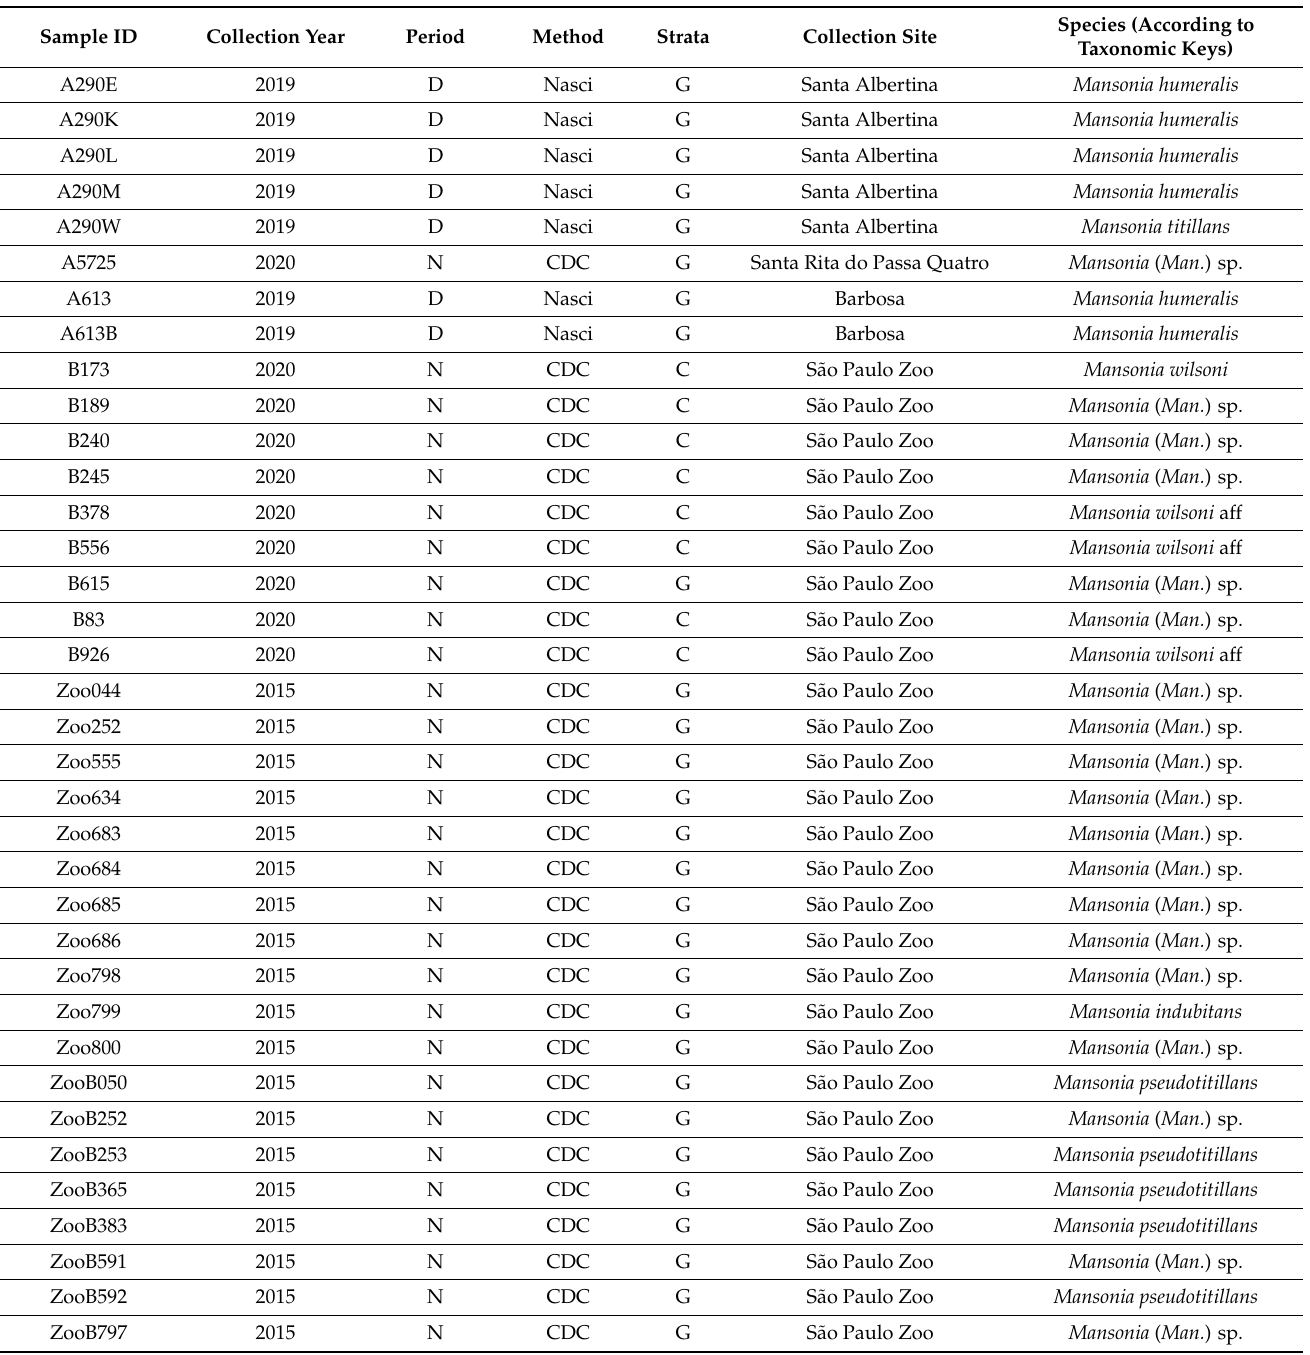
Table 1. Collected female Mansonia (Man.) spp., according to collection year, period, method, strata, and